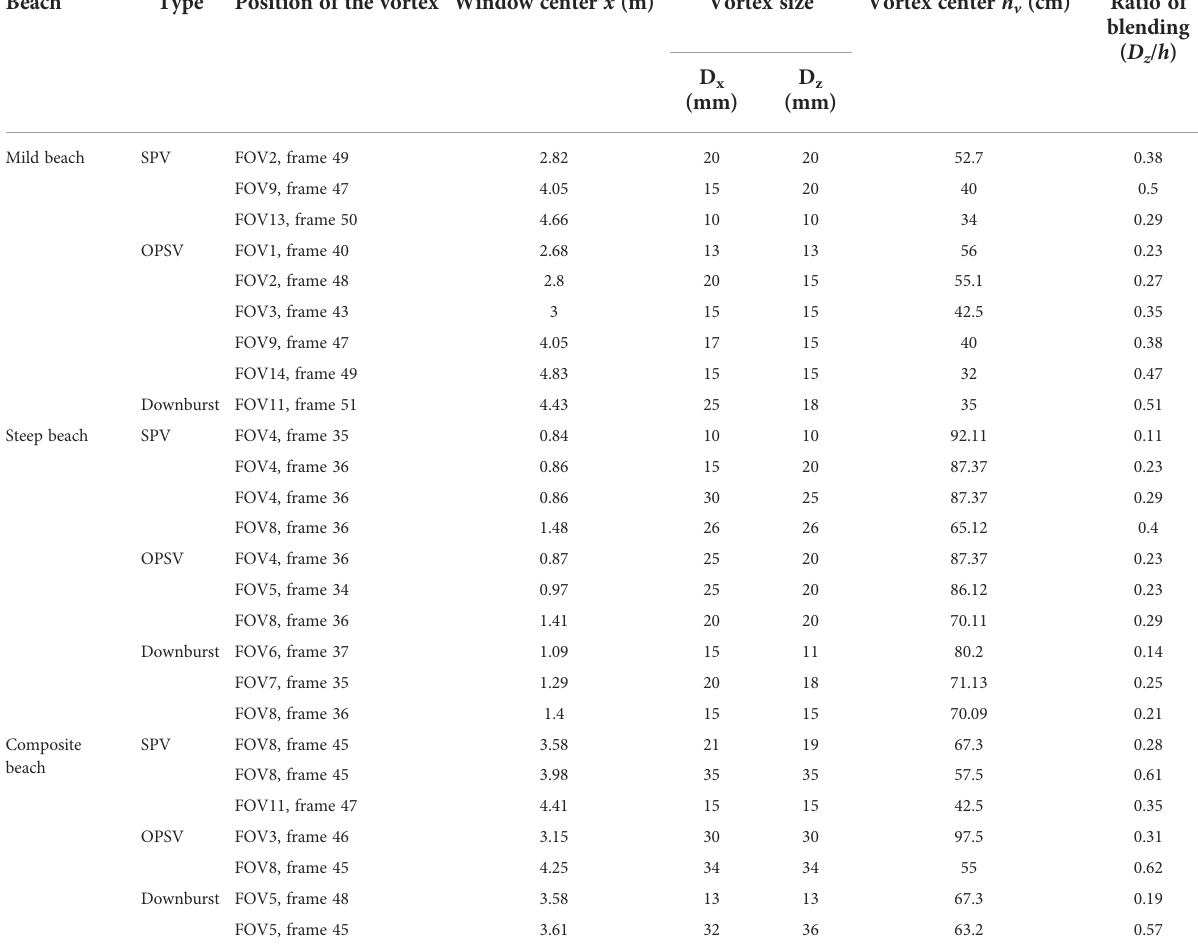
TABLE 4 Scale of the vortex structure. Beach